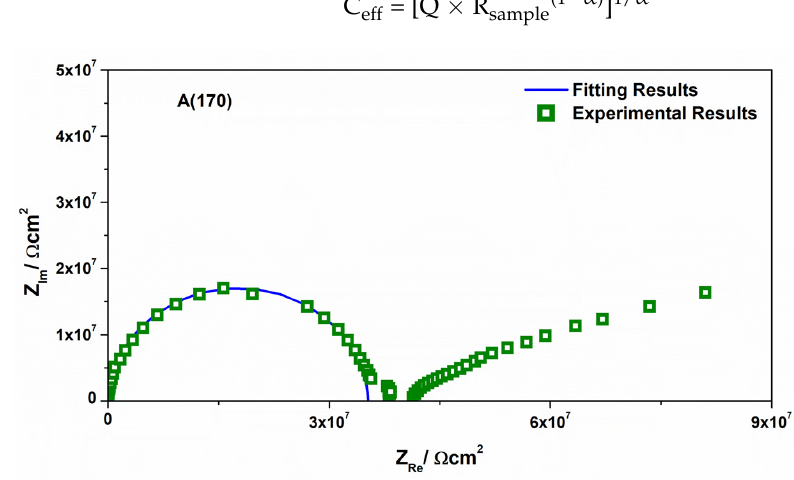
Figure 6. Nyquist plot spectra of A(170) [34].